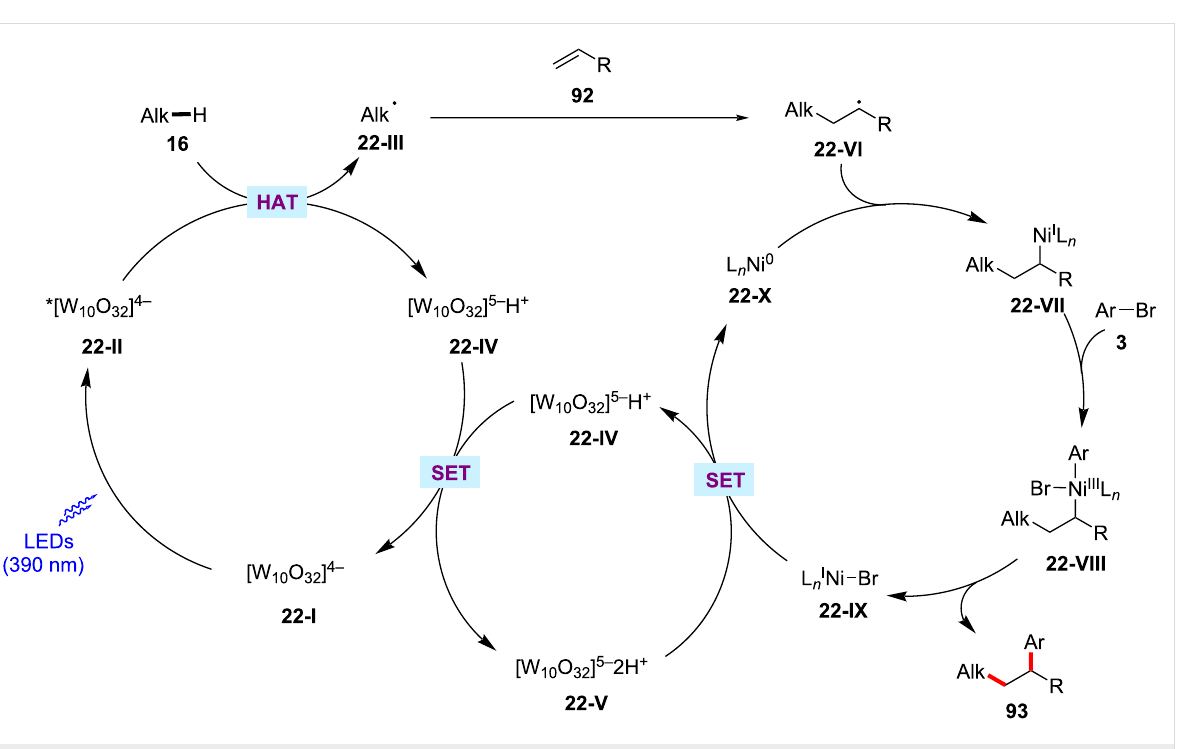
Figure 22: Proposed catalytic cycle for the decatungstate photo-HAT and nickel catalysis enabled alkene difunctionalization.